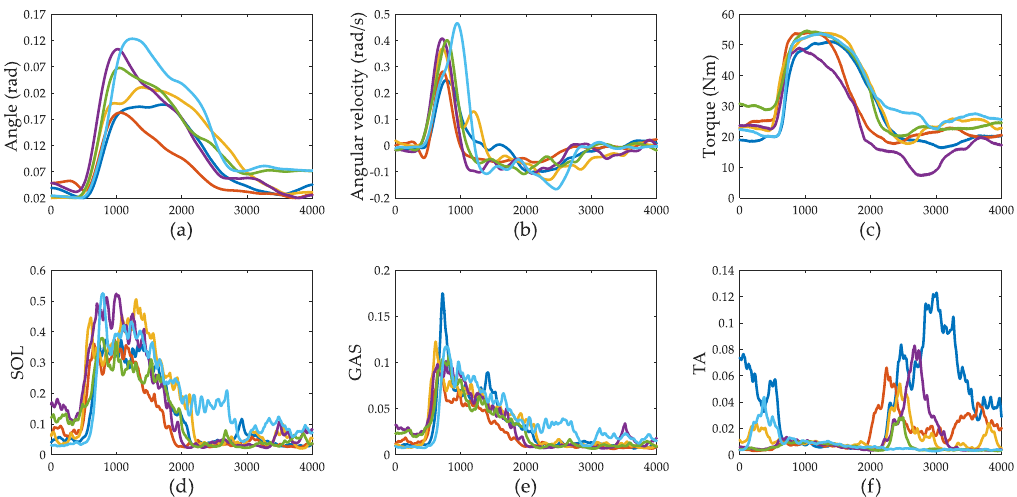
Figure 5. Experimental results for subject A. Each color represents one trial. There are six trials. The x-axis is the time in ms. ( a ) shows the measurement of ankle joint angle. ( b ) represents the ankle joint angular velocity. ( c ) shows the ankle joint torque. ( d ) shows the muscle activation level of SOL. ( e ) shows the muscle activation level of GAS. ( f ) shows the muscle activation level of TA.